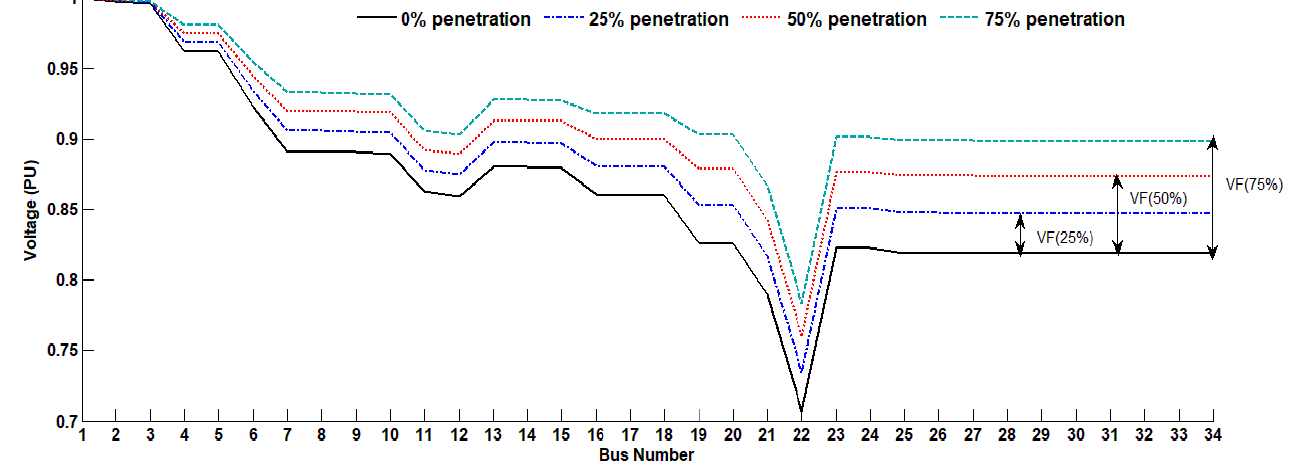
Figure 5. Voltage profiles for different penetration levels.